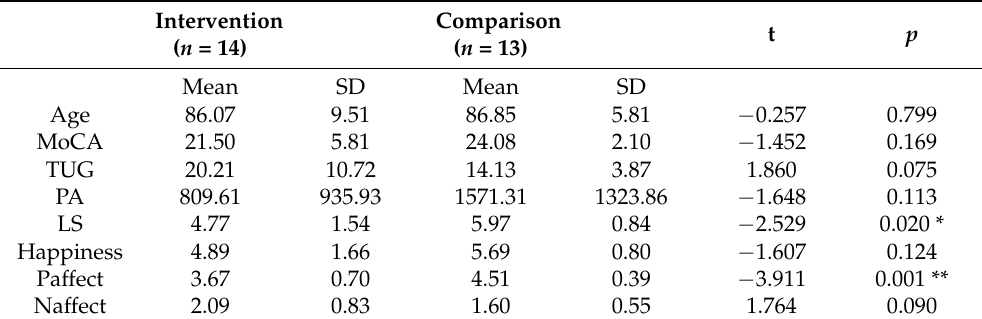
Table 2. Independent t-tests of baseline difference between the intervention and the compari- son